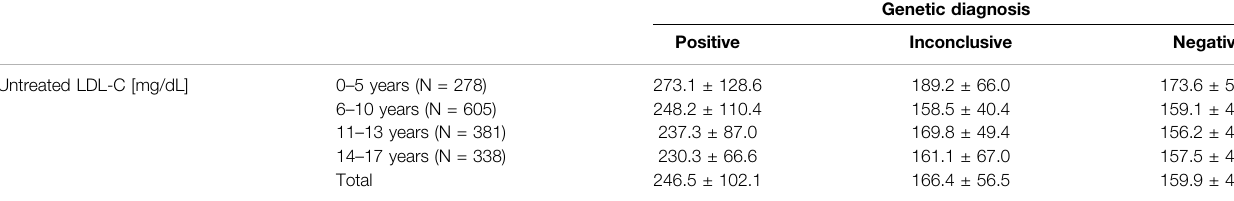
Genetic diagnosis Positive